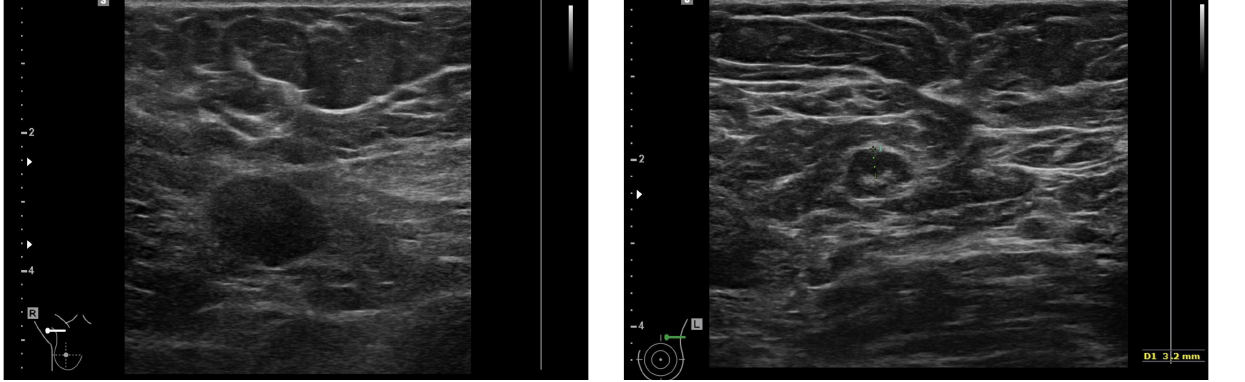
Fig. 2. Lymph node without fat hilum and abnormal L/T ratio.